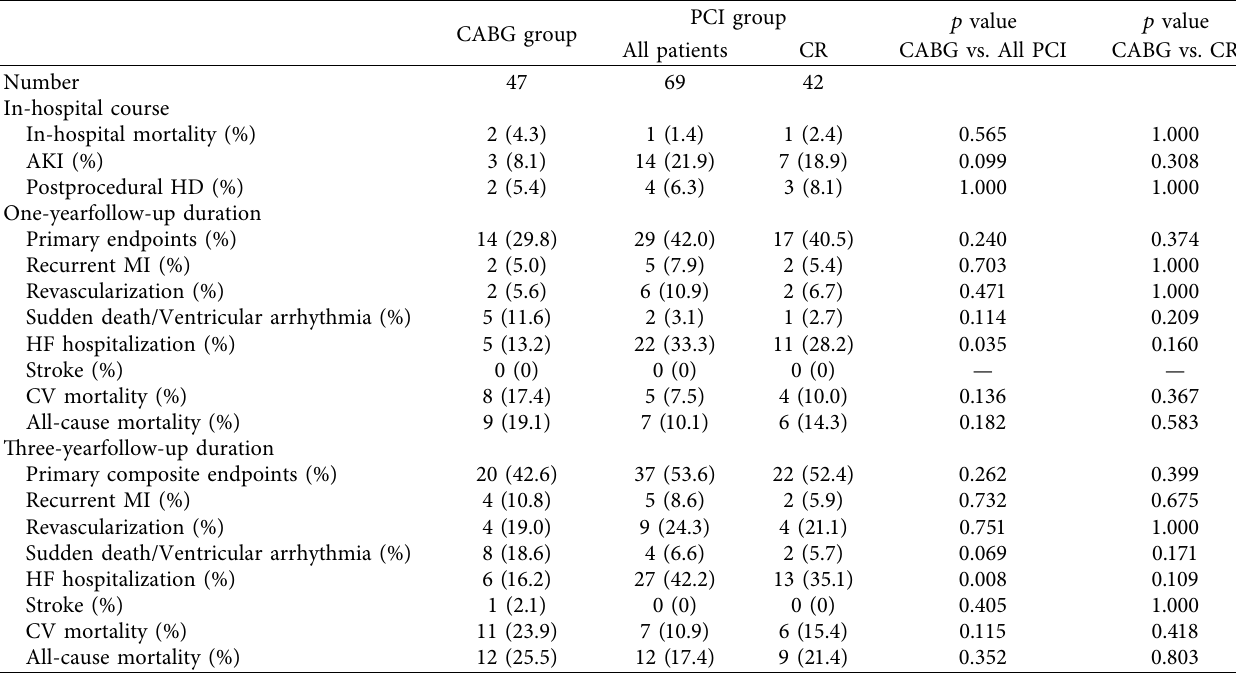
Table 3: Clinical outcomes of the study